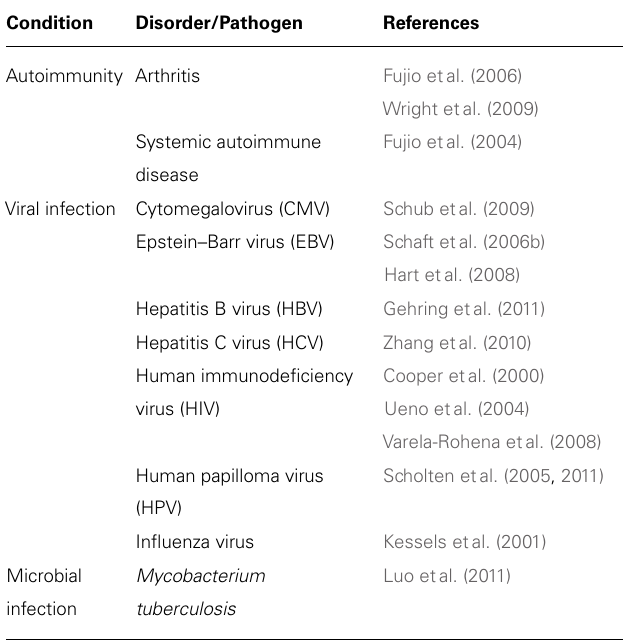
Table 1 | Use ofTCR-gene transfer for non-neoplastic